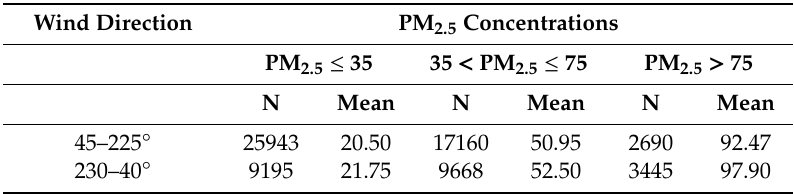
Table 5. Statistics of hourly PM 2.5 concentrations from all air quality monitoring stations, including Central, Tap Mun, Tsuen Wan, Yuen Long, and Tung Chung, as a function of corresponding hourly surface wind direction in Hong Kong